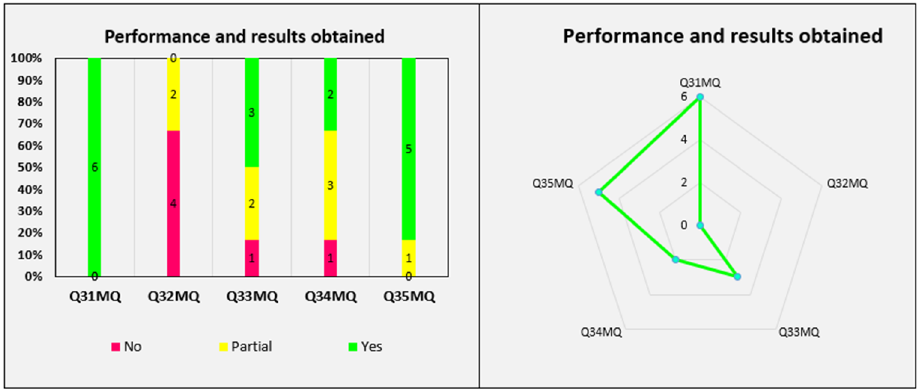
Figure 14. Answers regarding the risk management criteria.